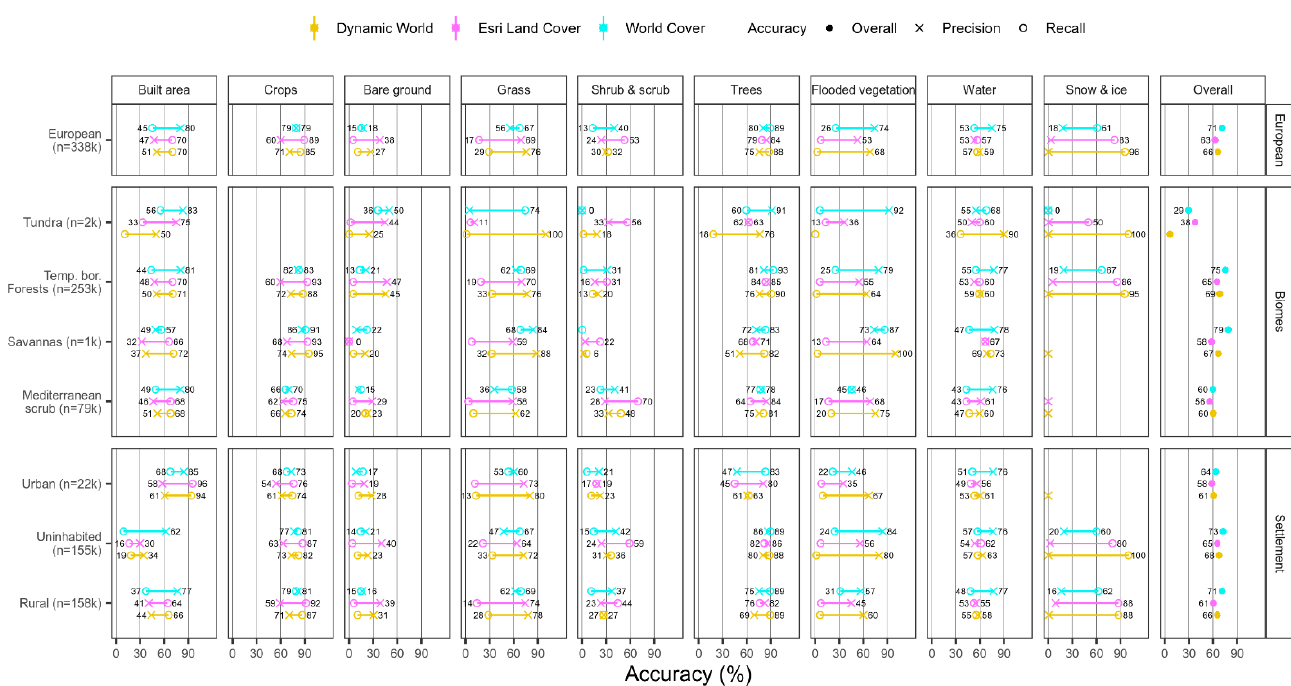
Figure 7. Accuracy of global 10 m land cover maps over Europe using point-based ground truth data from the LUCAS survey. Accuracy is stratified by LULC class, ecoregion and human settlement type. Accuracy is expressed as precision/user’s, recall/producer’s and overall accuracy based on a confusion matrix, with sample sizes indicated in thousands (K) in parentheses on the y-axis.